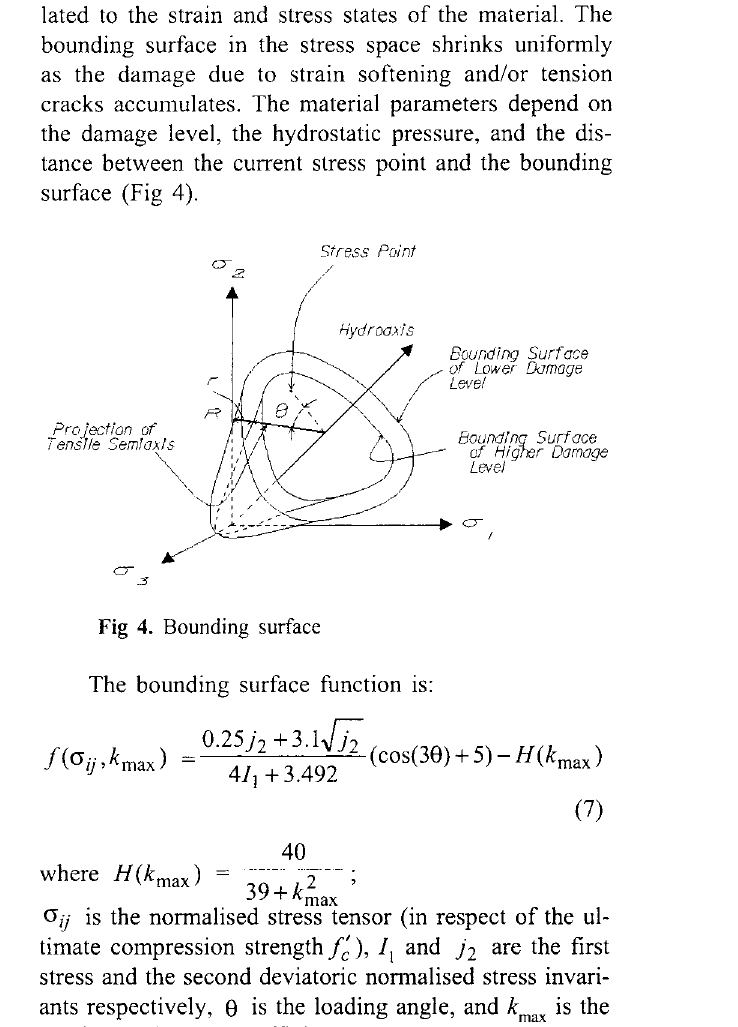
Fig 3. Analysis model The cross-section of the column was 400x400 mm, while the slab depth was 200 mm. The effect of slab column rigidity ratios was analysed using different cross sectional dimensions: the column cross-section was 300x300 mm with slab depth !50 mm in first case, and 500x500 mm column section with 250 mm slab depth in the second case.